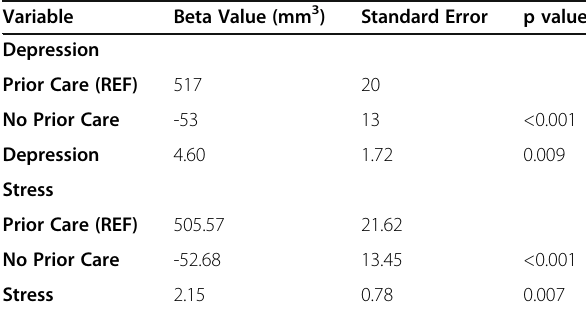
Table 3 Association between GMV in EM Patients and psychosocial factors